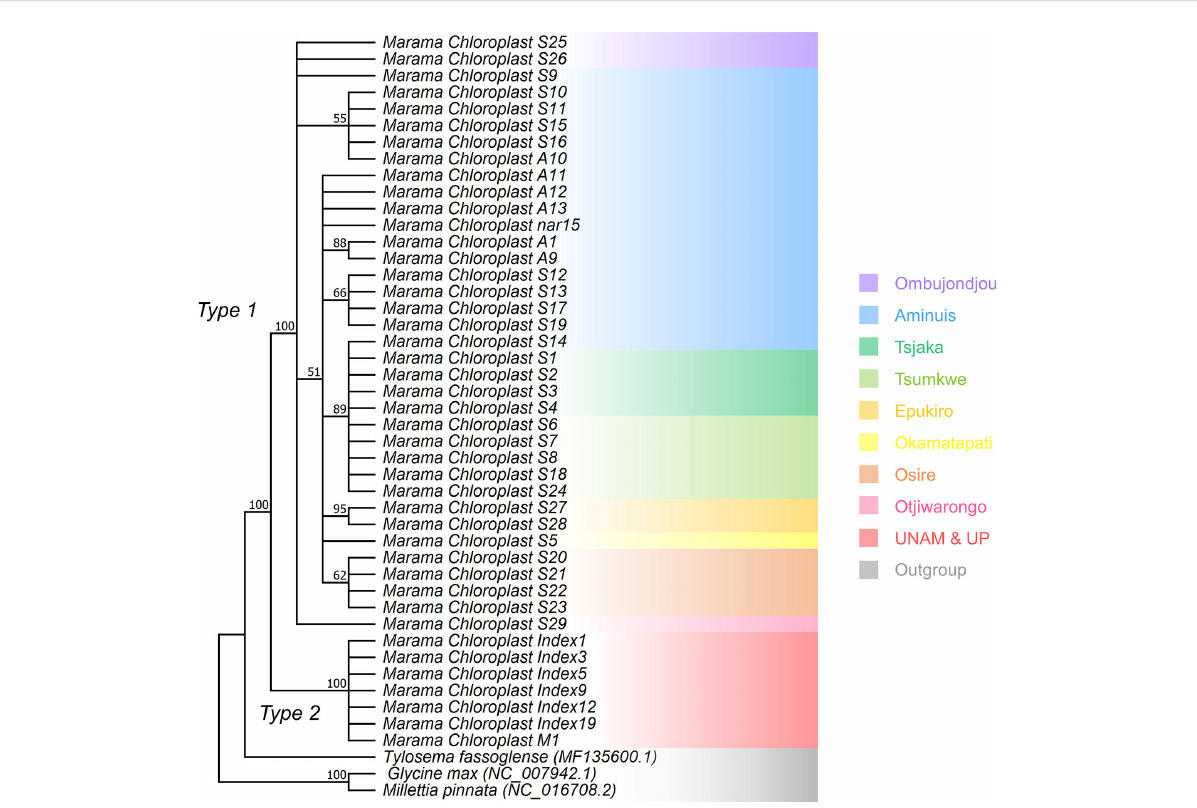
FIGURE 8 Maximum Likelihood (ML) phylogenetic tree based on the Jukes-Cantor model and the Tamura-Nei model showing the relationship of the chloroplast genomes of 43 independent T. esculentum individuals and three other Fabaceae species. T. fassoglense (MF135600.1), Glycine max (NC_007942.1), and Millettia pinnata (NC_016708.2) were used as outgroups. Bootstrap values from 1000 replicates were marked on the branches with 50% as cutoff. This was validated by the Maximum Parsimony (MP) method using the Subtree Pruning Re-grafting (SPR) algorithm with 1000 bootstrap replicates in Mega 11. Background colors indicate the geographic origin of the